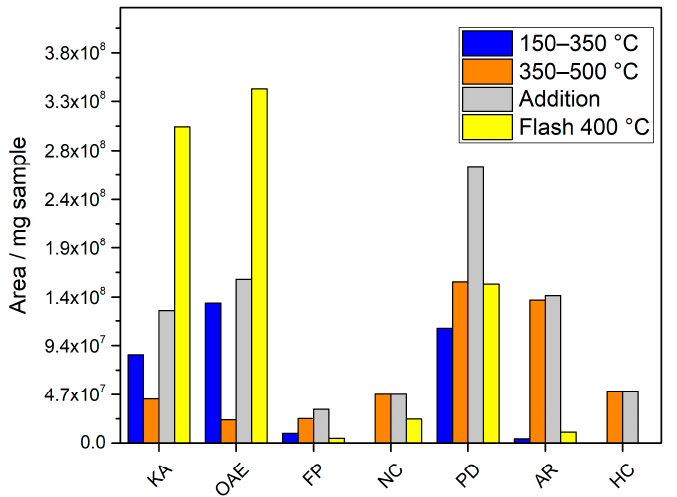
Figure 7. Comparison of area/mg sample values for the different functional groups.